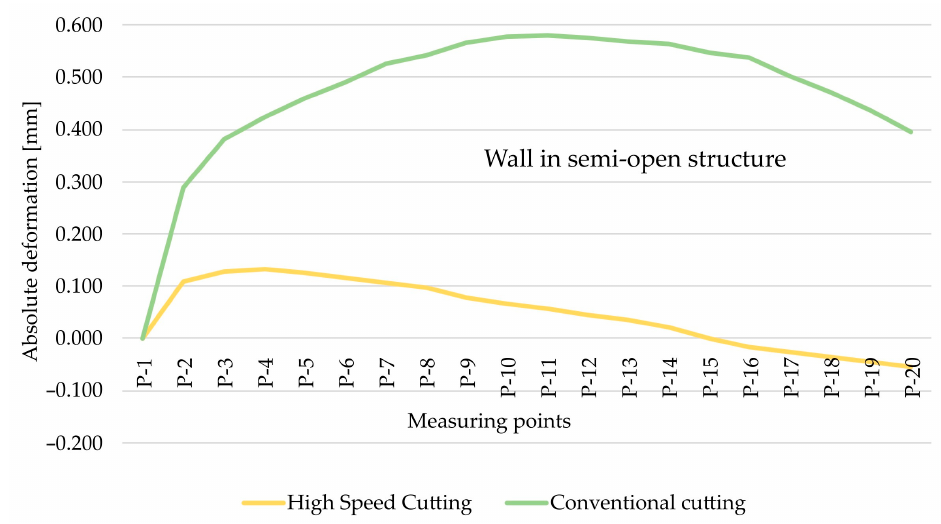
Figure 11. The comparison of absolute deformation for individual measurement points depending on the cutting type for the element with walls arranged a semi-open structure made of the EN AW-7075 T651 aluminium alloy.